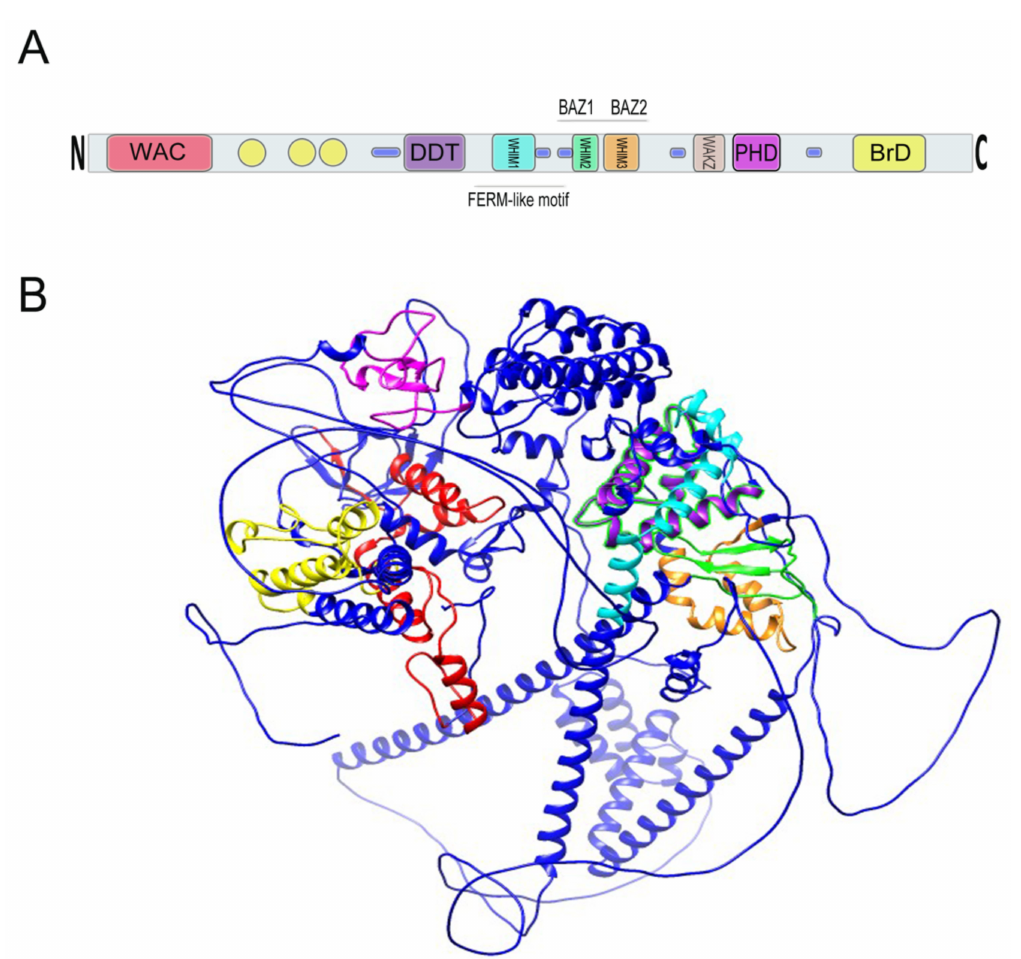
Figure 4. ( A ) Relative location of BAZ1B domains. Yellow circles are low complexity regions. Blue cylinders are coiled coil regions. The first N-terminally located domain is present in Acf1-related proteins in a variety of organisms. The WAC (WSTF/Acf1/cbp146) domain is within the DNA binding region of the Acf1 and is believed to be involved in DNA binding and is associated with the PHD finger and Brd domains in other proteins [18,19]. It spans residues 21–120 on BAZ1B. DDT stands for DNA-binding homobox-containing proteins and Different Transcription and chromatin remodeling factors. Such proteins share this domain, which spans almost 60 residues and is associated exclusively with nuclear domains including PHD finger, Brd, and DNA-binding homeodomain [20]. It spans residues 604–668 on BAZ1B. Residues 724–773 on BAZ1B locate WHIM1 conserved the α helical motif that along with the WHIM2, WHIM3, and DDT domain comprise an α helical module that is reported to interact with linker DNA and the SLIDE domain of ISWI proteins [21]. WHIM2 domain spans residues 899 to 936 on BAZ1B and contains the D-TOX E motif that is also known as the Williams–Beuren Syndrome DDT (WSD) motif. It is conserved from yeast to animals [22]. PHD zinc finger (spanning 1184 to 1234) and bromodomain (1356–1426) are the two C-terminally located domains. Refer to the main text for more information about these domains. ( B ) A 3D representation of BAZ1B based on its PDB file (PDB ID: Q9UIG0) predicted by the AlphaFold protein structure database [23]. Domains are highlighted with different colors as follows: BrD: yellow; PHD: